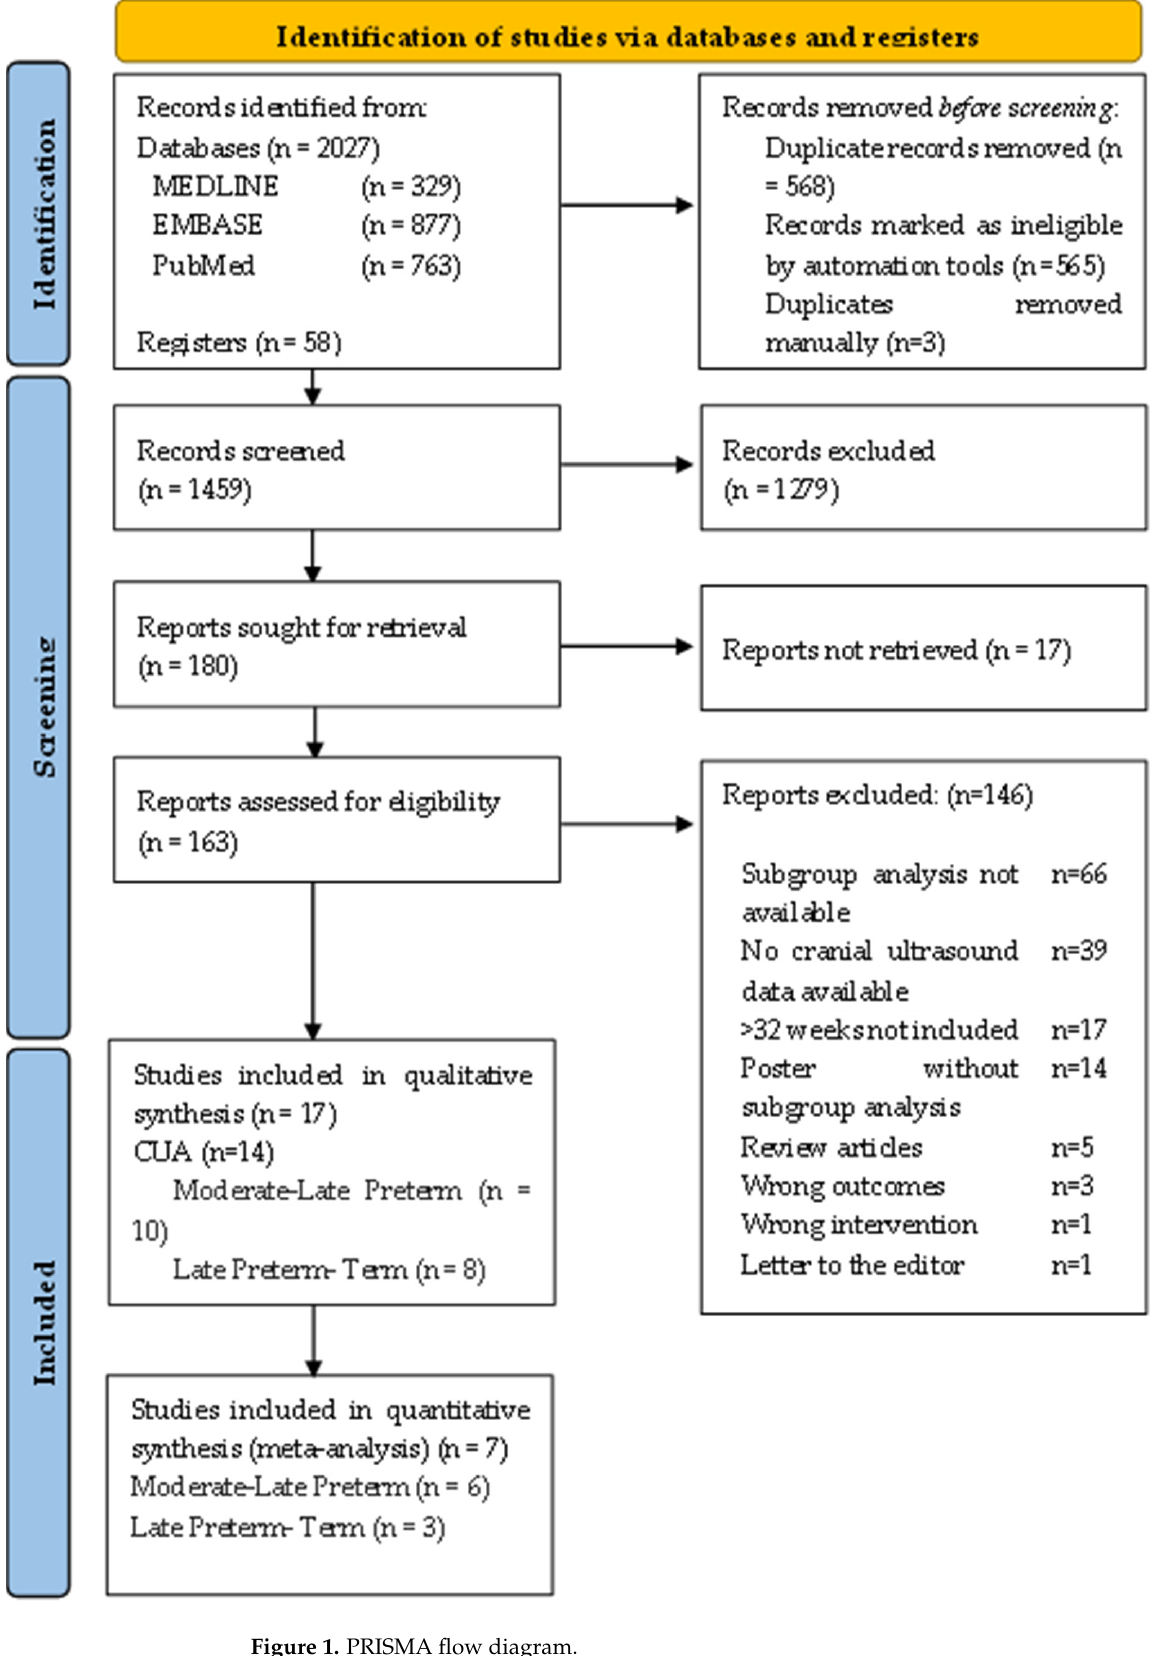
Figure 1. PRISMA flow diagram.